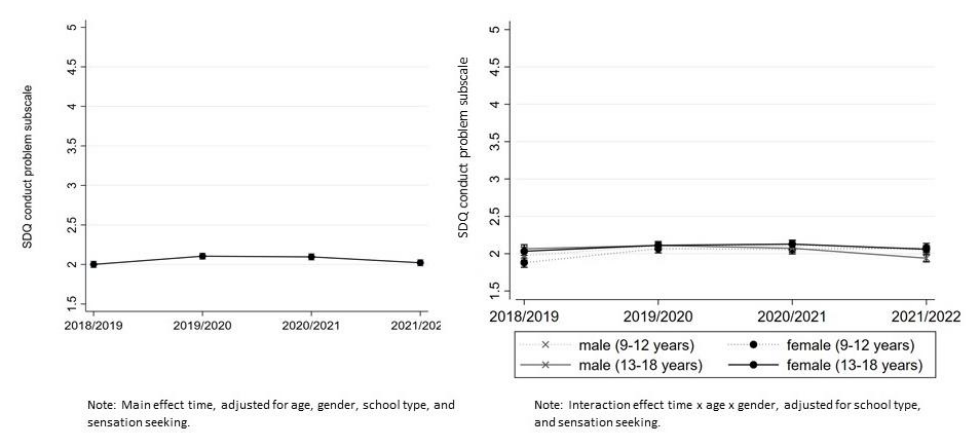
Figure 4. Mean SDQ subscale conduct problem scores from 2018–2019 to 2021–2022, cross-sectional ranges from 0 to 10 (abnormal problem behavior).